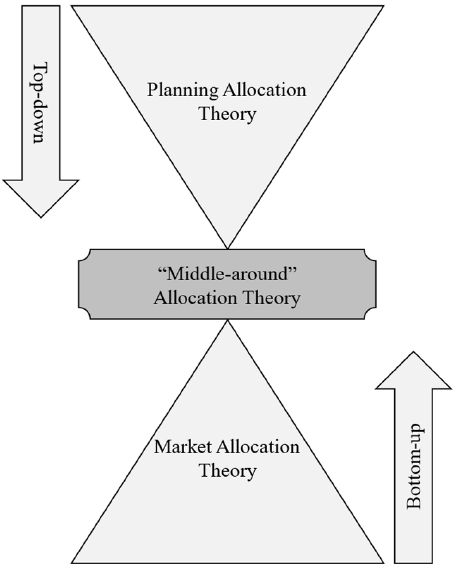
Figure 5. “Middle-around” theory in allocation of land factors.